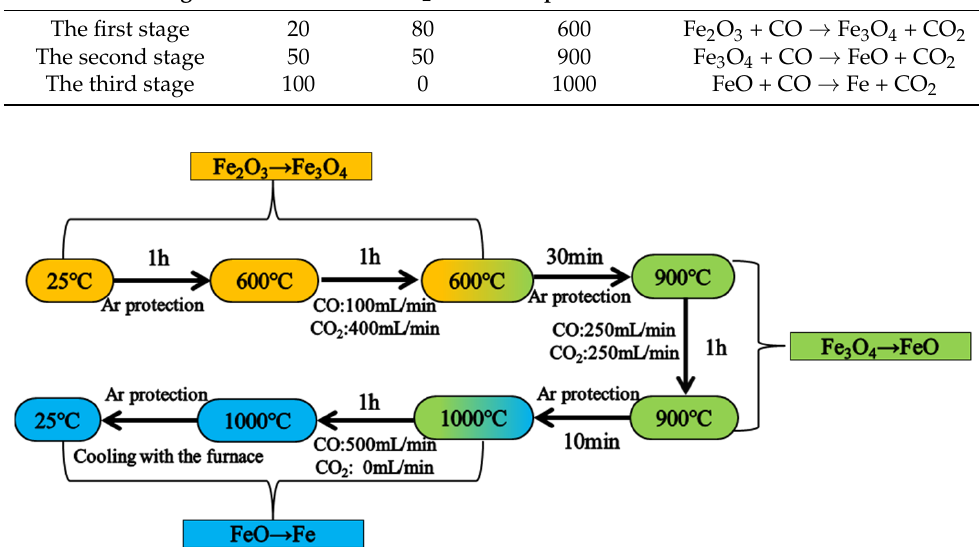
Figure 1. Flow chart for the reduction swelling experiment of pellets.